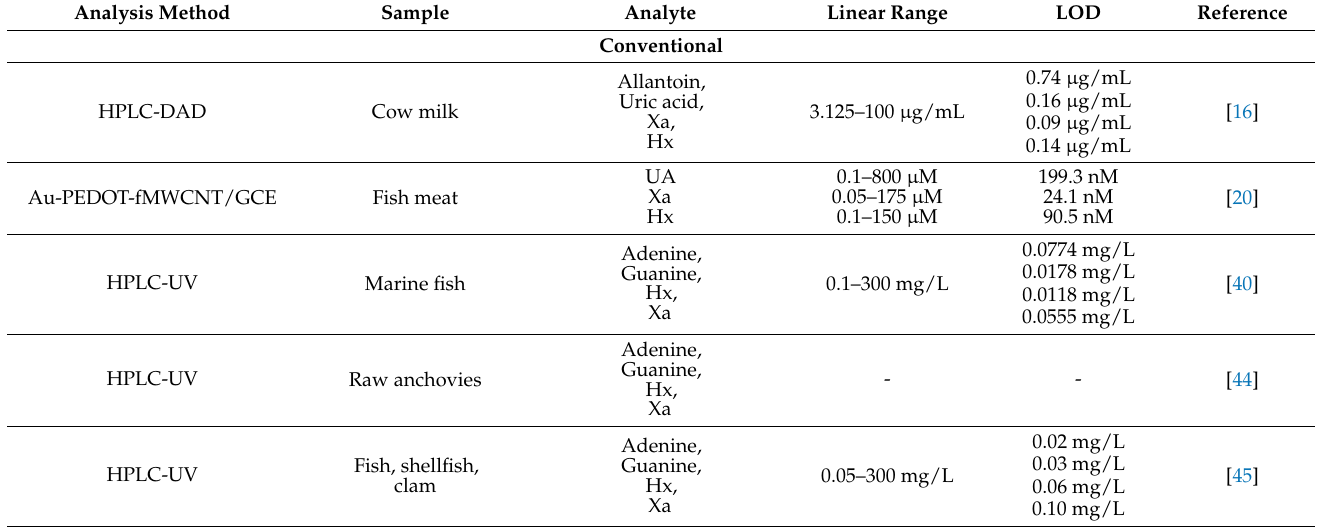
Table 4. Comparison of the analytical performance of conventional techniques and nanotechnology- based